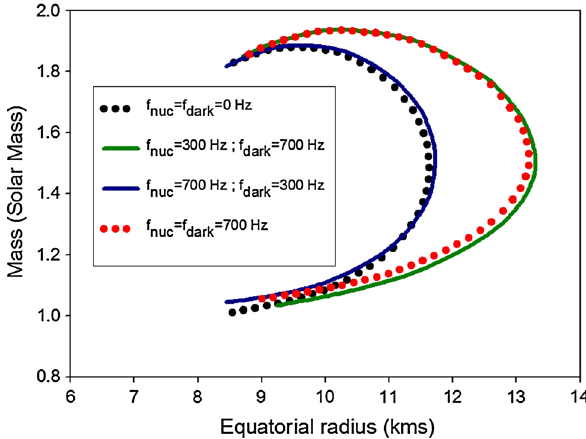
Fig. 5 Plots of total mass vs. equatorial radius of static, rigidly rotating and differentially rotating neutron stars mixed with interact- ing fermionic asymmetric dark matter with fixed dark matter central enthalpy (0 . 24 c 2 ) and varying nuclear matter central enthalpies